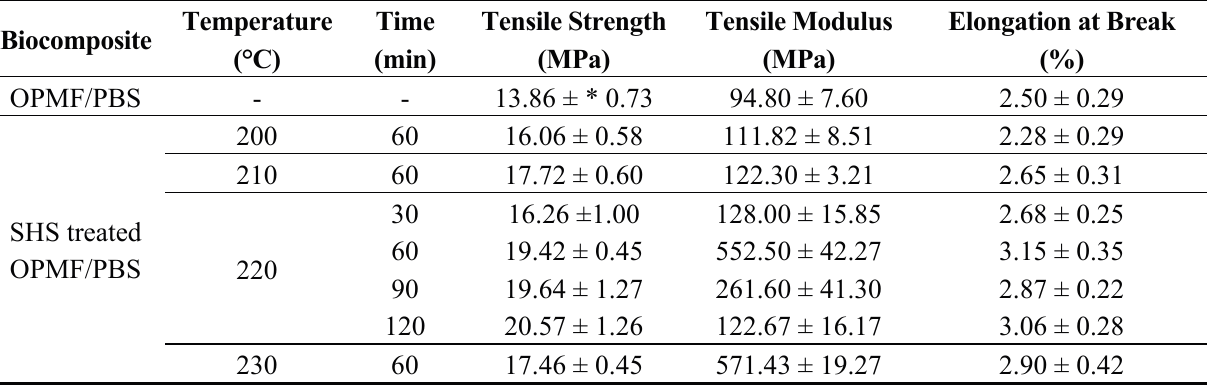
Table 1. Tensile properties of untreated OPMF/PBS and SHS-treated OPMF/PBS biocomposites.